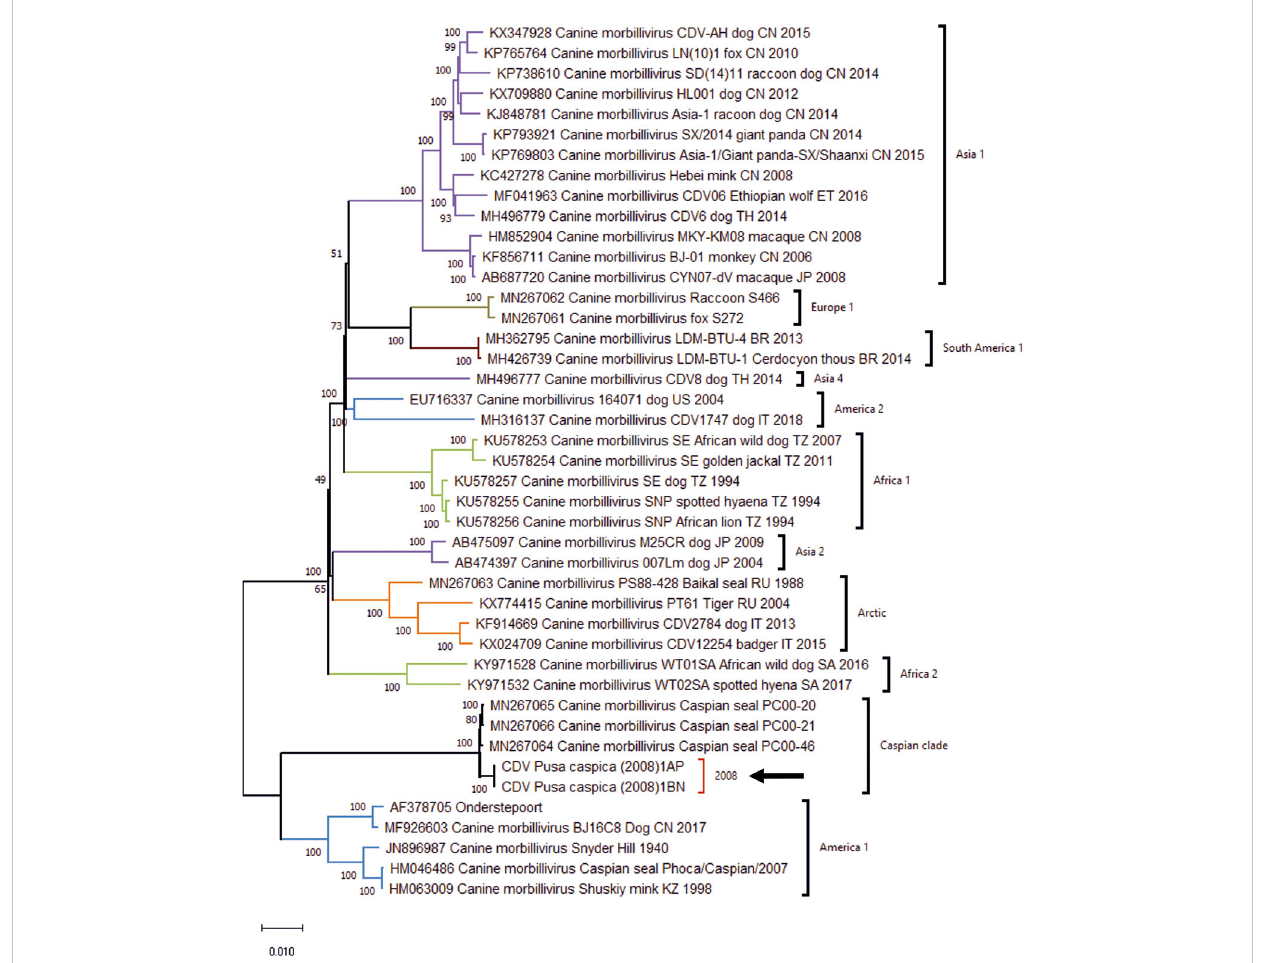
FIGURE 1 Maximum Likelihood phylogenetic tree for Canine Distemper Virus whole genome sequences, generated using the General Time Reversible model with invariant sites and gamma distribution for evolutionary rates (GTR+I+G), with 1000 bootstrap replicates. Position of the Caspian clade, and genomes for the 2008 isolates is highlighted by arrow. Regional annotation of clades follows Jo et al., (2019).